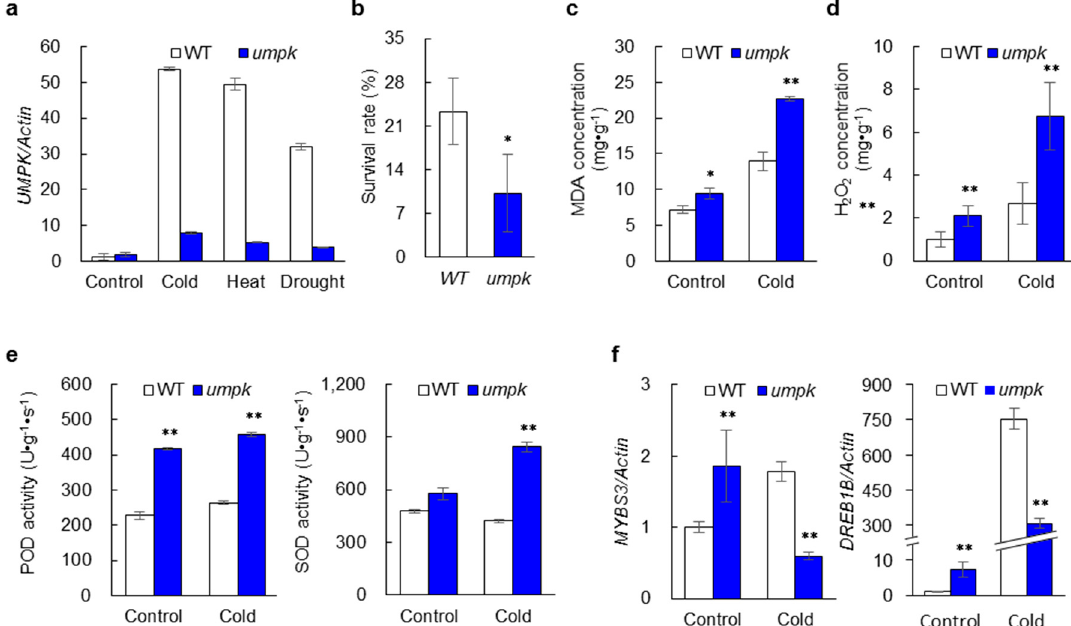
Figure 4. Response of UMPK to abiotic stresses. ( a ) Expression levels of UMPK under various stress treatments in the WT and the mutant ( n = 3). Actin1 was used as the internal control. ( b ) Survival rates of the WT and the mutant after cold treatment (3 replicates, 30 plants in each replicate). ( c ) Concentrations of malondialdehyde (MDA) in the WT and the mutant under normal and cold conditions ( n = 5). ( d ) Concentrations of hydrogen peroxide (H 2 O 2 ) in the WT and the mutant under normal and cold conditions ( n = 5). ( e ) Activities of peroxidase (POD) and superoxide dismutase (SOD) in the WT and the mutant under normal and cold conditions ( n = 5). ( f ) Expression levels of two cold-inducible genes in the WT and the mutant under normal and cold conditions ( n = 3). Actin1 was used as the internal control. Data represent means ± sd. Significant differences are according to the Student’s t -test at * p < 0.05 and ** p < 0.01.